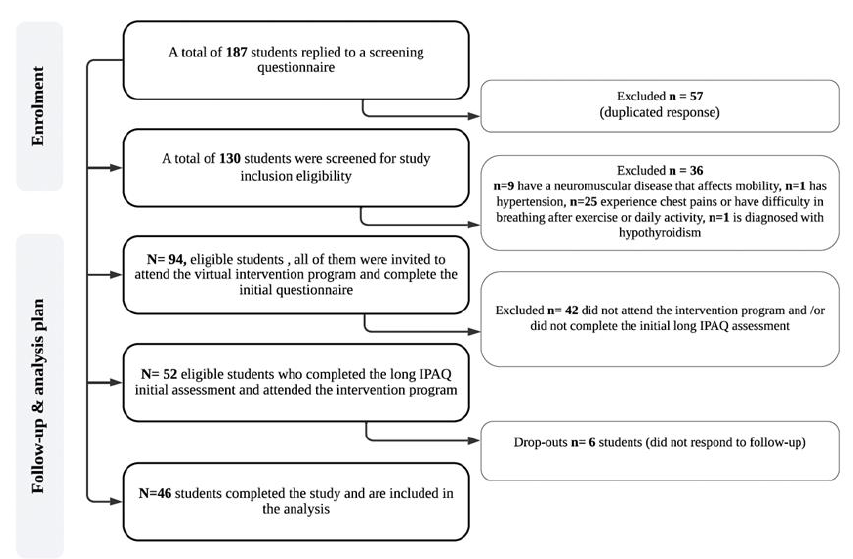
Figure 1. Study flow diagram .